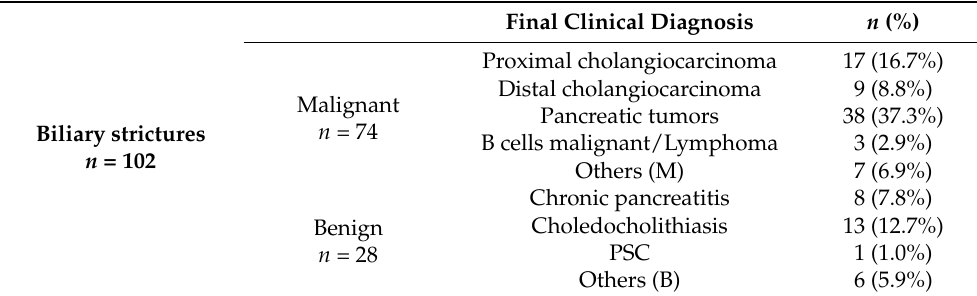
Table 2. Study’s final clinical diagnosis after conclusive 12-month follow-up and/or postoperative histology.